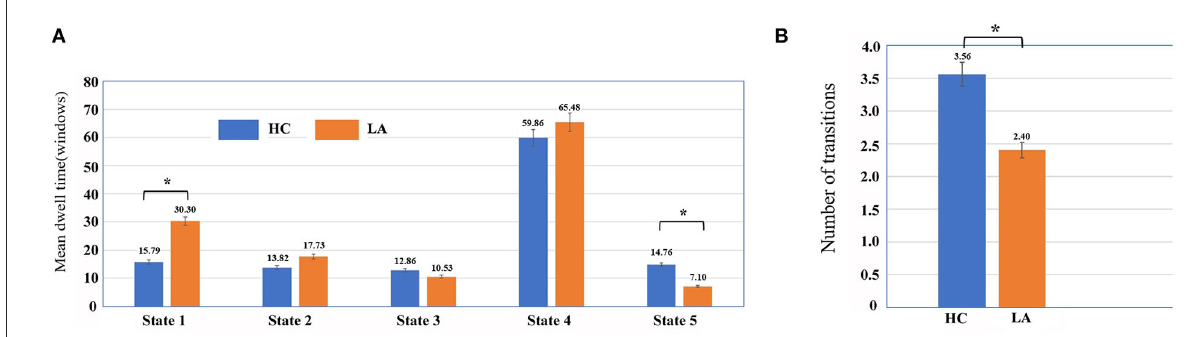
FIGURE4 Temporal properties of functional connectivity state analysis in LA and HC groups, including mean dwell time (A) and number of transitions (B) . Asterisks represent significant group differences ( p < 0.05, FDR corrected).